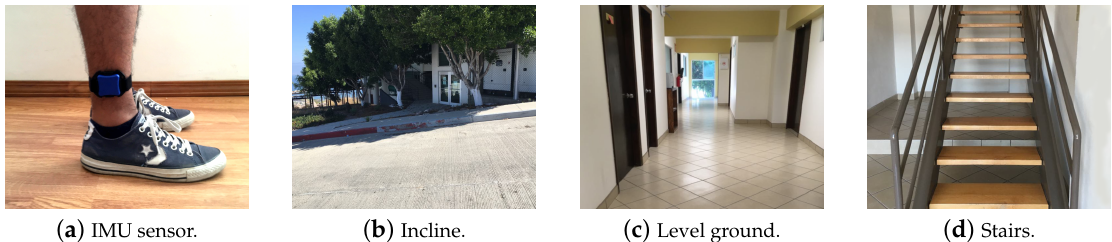
Figure 2. Setup of the experiment: the Inertial Measurement Unit (IMU) configuration ( a ) and the environments in which the gait activities were performed ( b )–( d